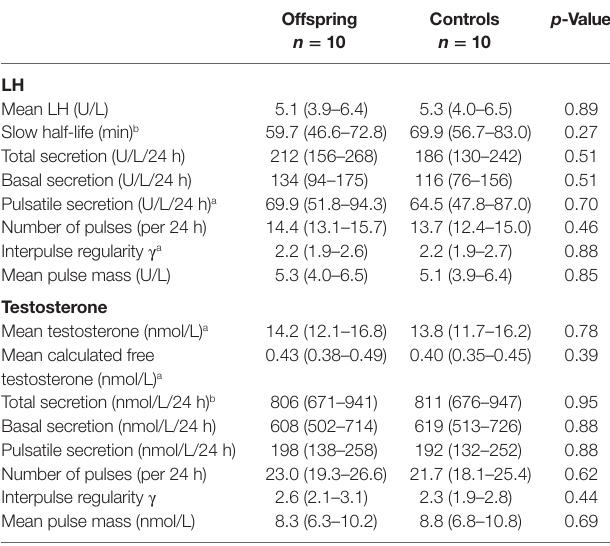
TaBle 2 | lh and testosterone secretion parameters in male offspring of long-lived families and